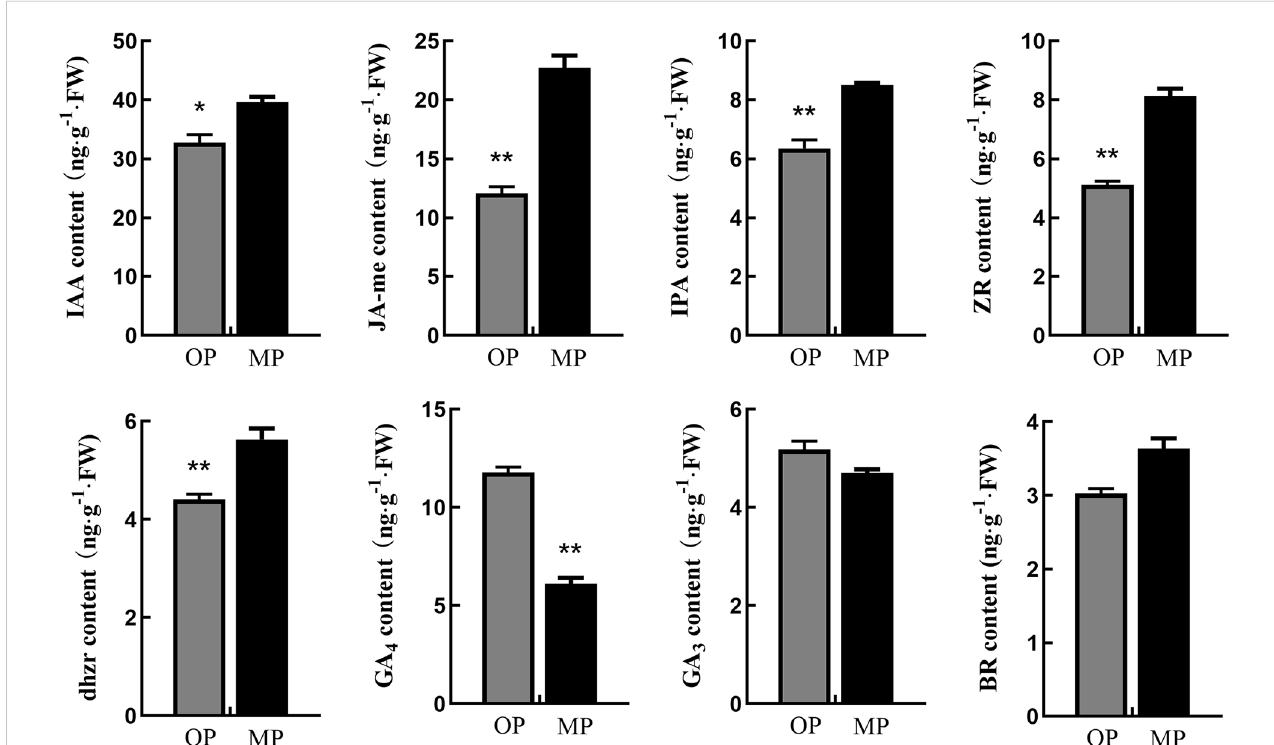
FIGURE 3 Hormone contents in stem tips of the wild type (OP) and mutant (MP). BR, brassinolide; DHZR, dihydrozeatin riboside; GA3 and GA4, gibberellins; IAA, indole-3- acetic acid; IPA, indolepyruvic acid; JA-Me, methyl jasmonate; ZR, zeatin riboside. Error bars indicate the standard error. * p < 0.05, ** p < 0.01 (Duncan ’ s test).